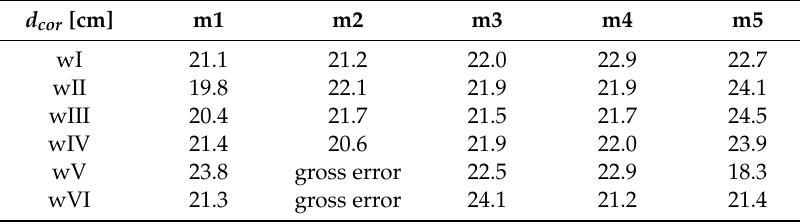
Table 11. Calculated slabs thicknesses based on the corrected dielectric